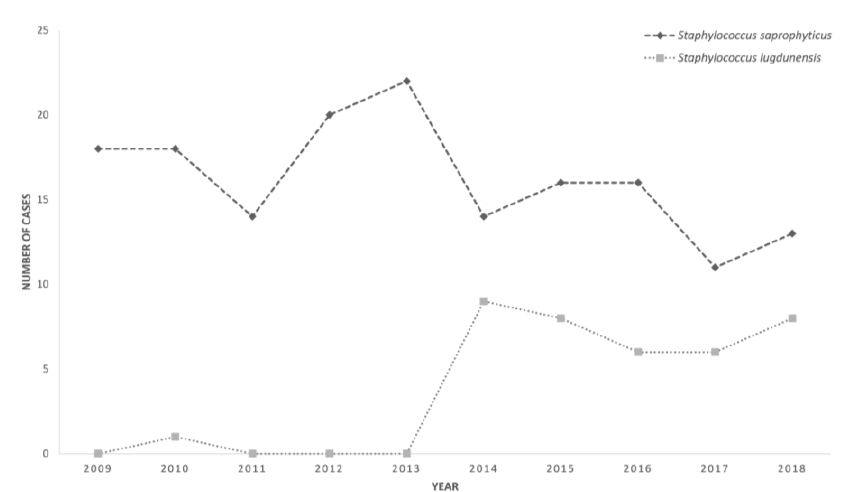
Figure 2. Cases of S. saprophyticus - and S. lugdunensis -associated urinary tract infection in 2009–2018.